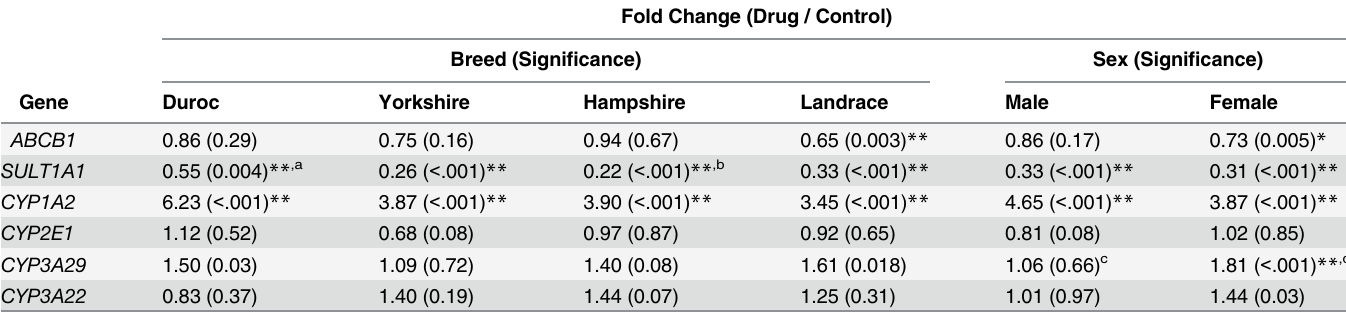
Table 4. The fold-change (Significance) 1,2 between animals given a drug and the control within each breed and sex for fenbendazole across target genes.